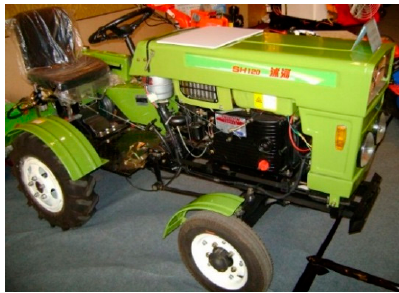
Figure 9. SH (Shandong) 11 kW 4 WT (Photo: Brian Sims) .